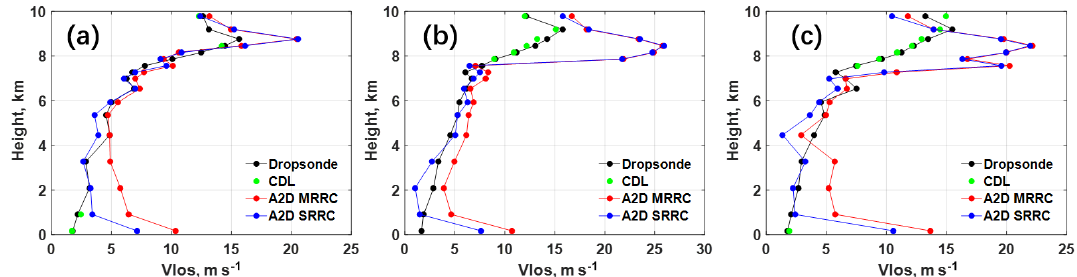
Figure 13. LOS velocity from dropsonde (black), CDL (green), A2D MRRC (red), and A2D SRRC (blue) on (a) 08:27:07, (b) 08:33:06, and (c) 08:39:05UTC, 23 September 2016.